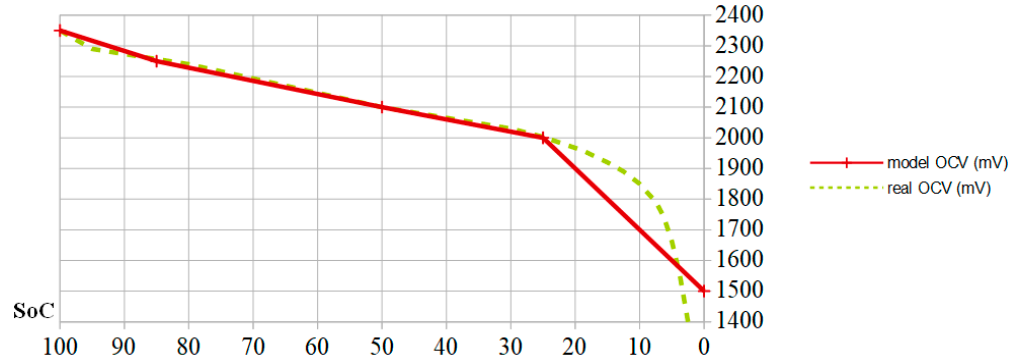
Figure 2. Linearization of the OCV (SoC) curve (SoC) by parts for a 24 Ah lead-acid cell.